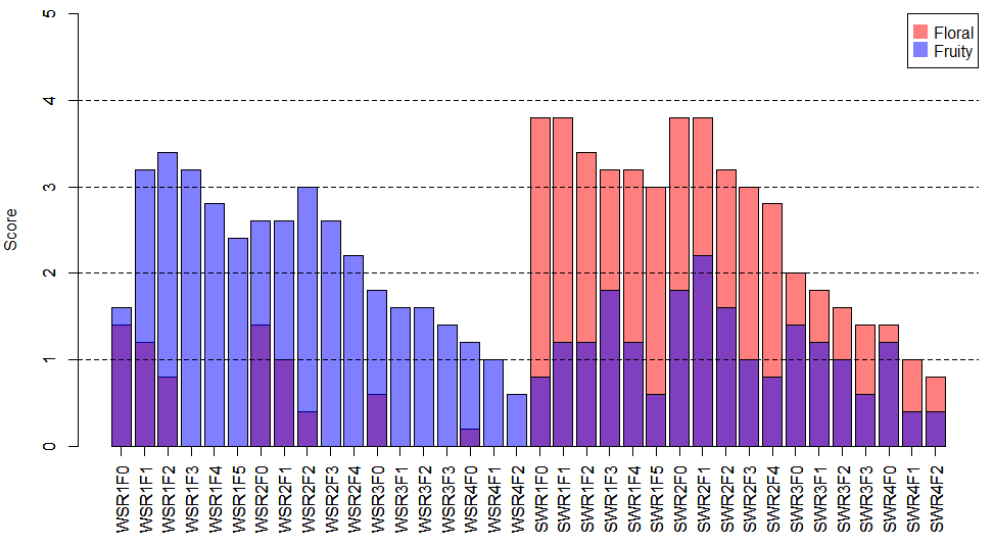
Figure 5. Sensory evaluation scores of the aroma of black teas processed under various conditions. Purple is the color that appears when red and blue are stacked, indicating that this sample has both floral and fruity aromas.